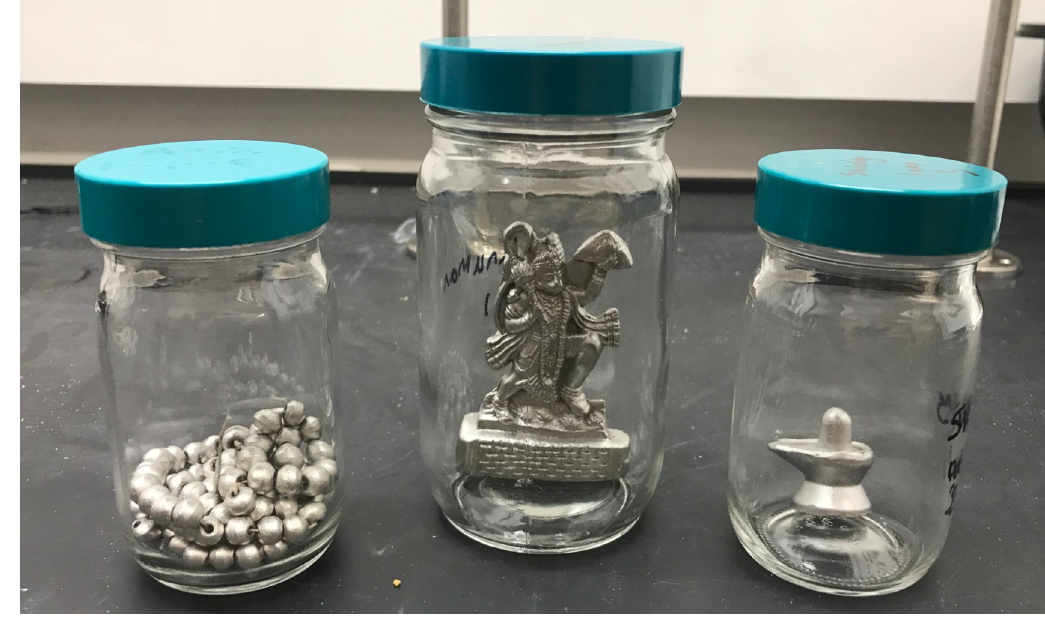
Fig 1. Amalgams can be molded into a variety of shapes including malas (necklaces), deities, and shiva lingams (L !